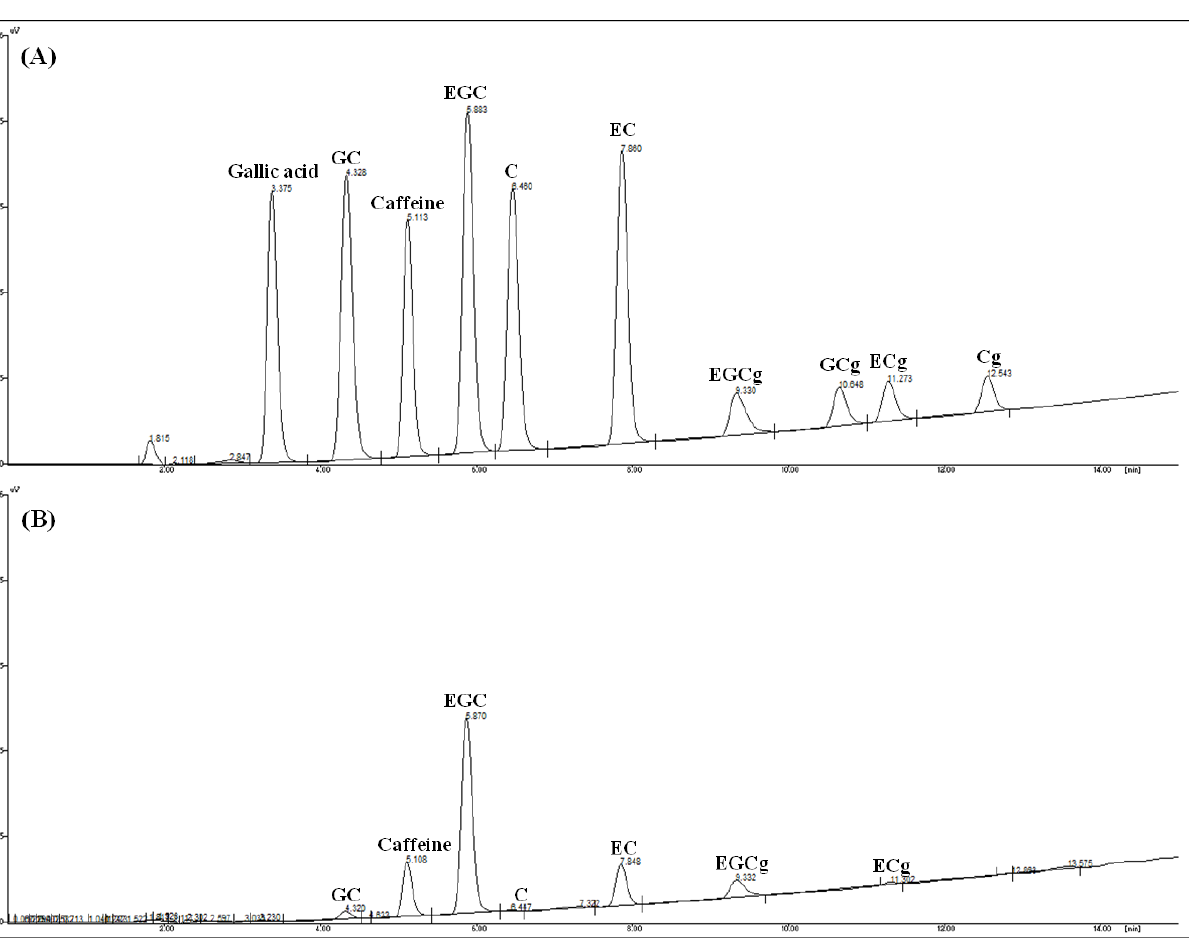
Figure 3. HPLC chromatograms of standard solution of caffeine and catechins ( A ) and extracts ( B ). GC, (+)-gallocatechin; EGC, (−)-epigallocatechin; EC, (−)-epicatechin; EGCg, (−)-epigallocatechin gallate; GCg, (+)-gallocatechin gallate; ECg, (−)-epicatechin gallate; Cg, (+)-catechin